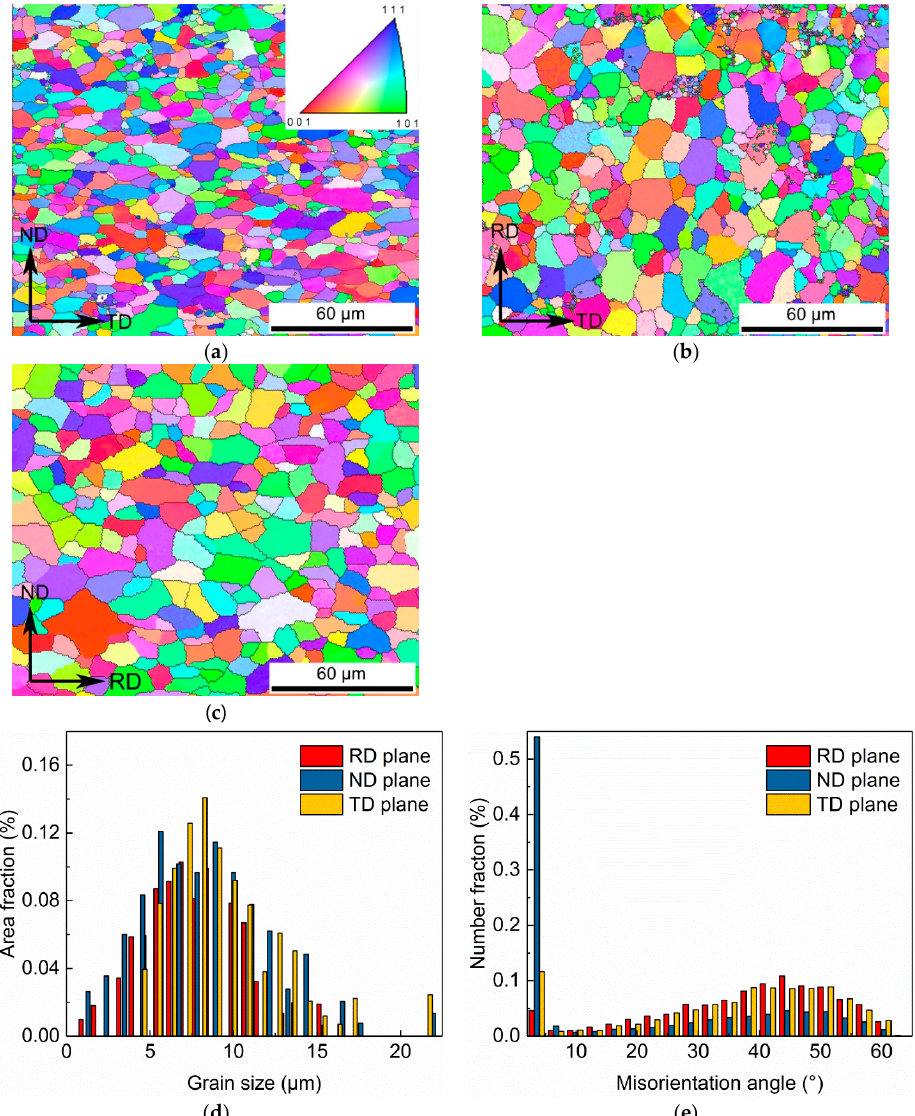
Figure 2. EBSD results of the grain size in the RD plane ( a ), ND plane ( b ), and TD plane ( c ); the grain size distribution ( d ); and the grain orientation angle ( e ) of the 2 mm thick fine-grained 5A70